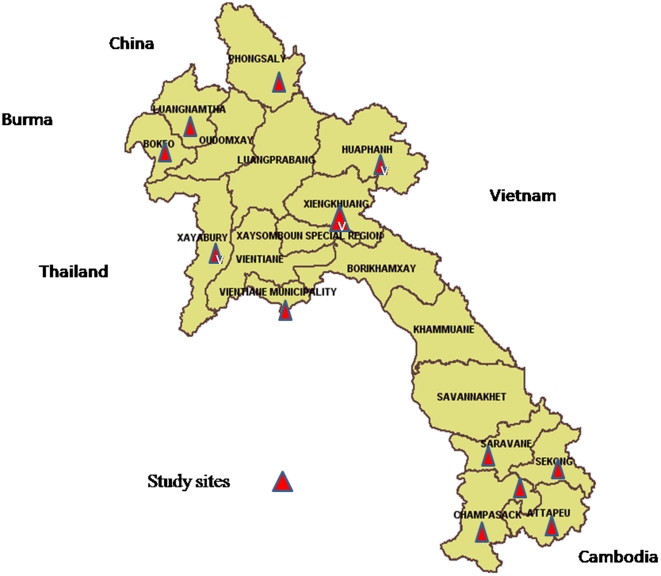
Map of study site.